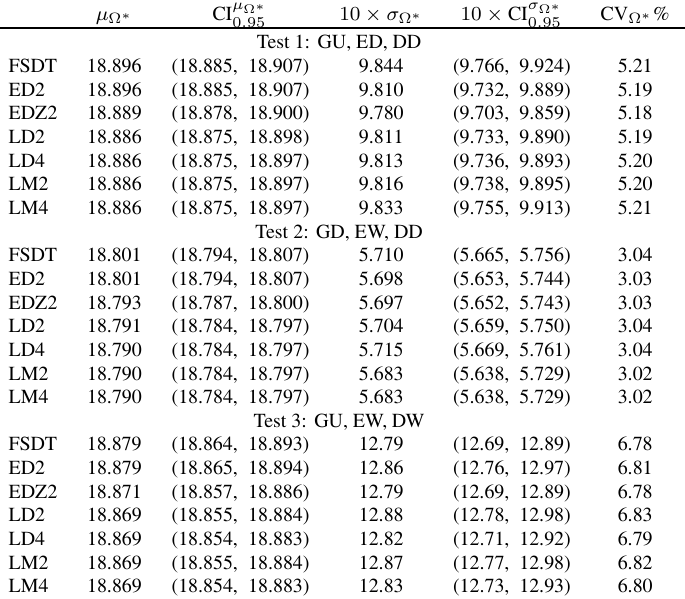
Ω ∗ statistic estimators in the case of the symmetric laminate, fi rst material and a